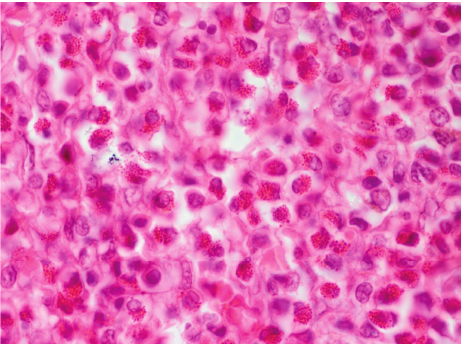
Figure 10: Section of another aorta infected with S. lupi depicting marked infiltration of eosinophils and plasma cells ( × 400).